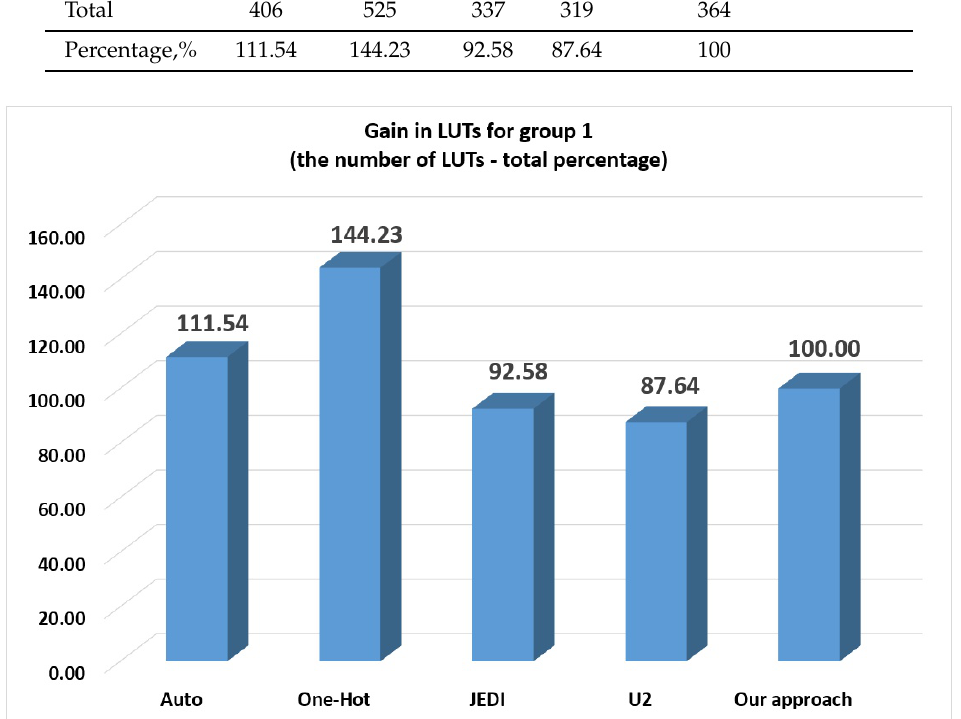
Figure 12. Gain in LUTs for group 1 (LUT count—total